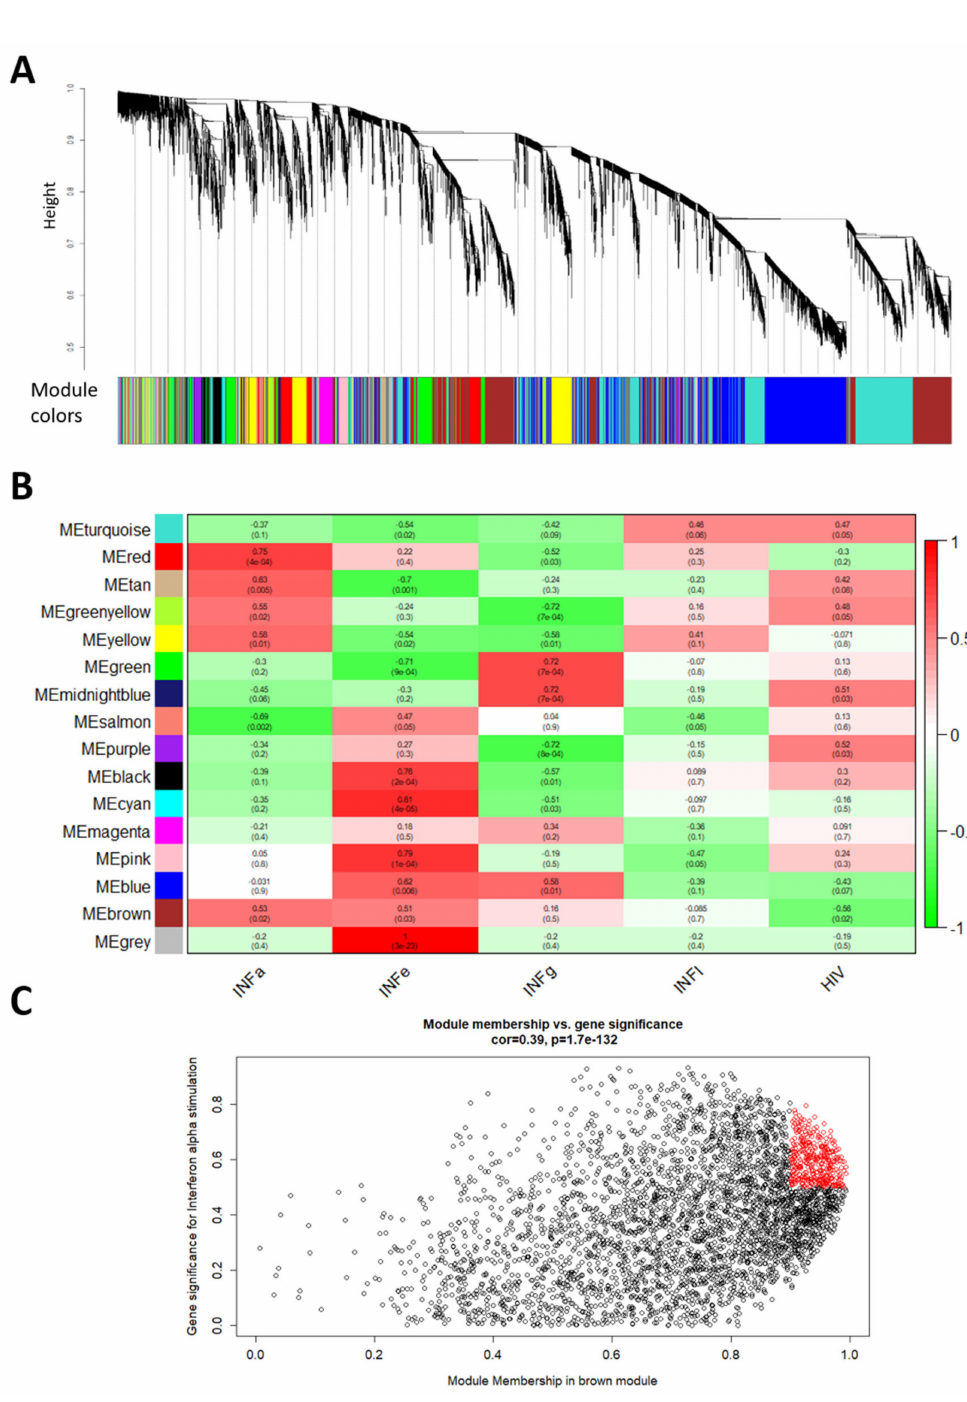
Figure 3. Weighted gene co-expression network analysis (WGCNA). ( A ) Hierarchical dendrogram of an unsigned, single-block gene co-expression network created based on bi-weight mid-correlation between gene expression over all samples. ( B ) Module–trait heatmap displaying the correlation between the eigengene of a module and the trait status (IFN- α , IFN- ε , IFN- γ , IFN- λ or HIV-1). Red indicates a positive correlation, while green indicates a negative correlation. ( C ) Scatterplot showing for each individual gene within the brown module the gene significance for IFN- α stimulation vs. its module membership. Genes that are considered hub genes are depicted in